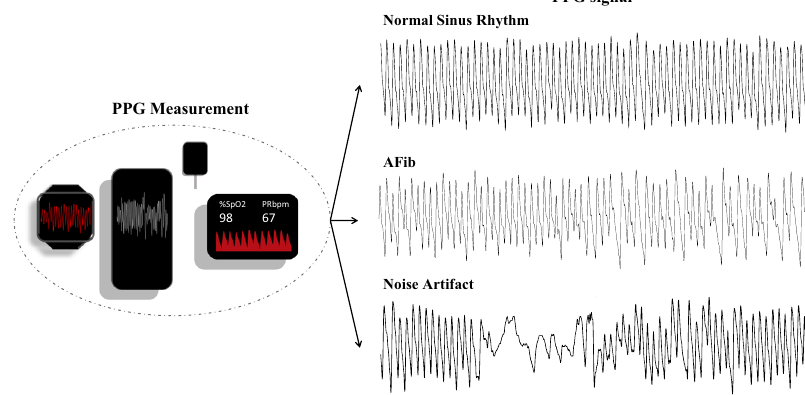
Fig. 1 PPG signal acquired using a wearable device and typical waveforms representing NSR, AF, and noise